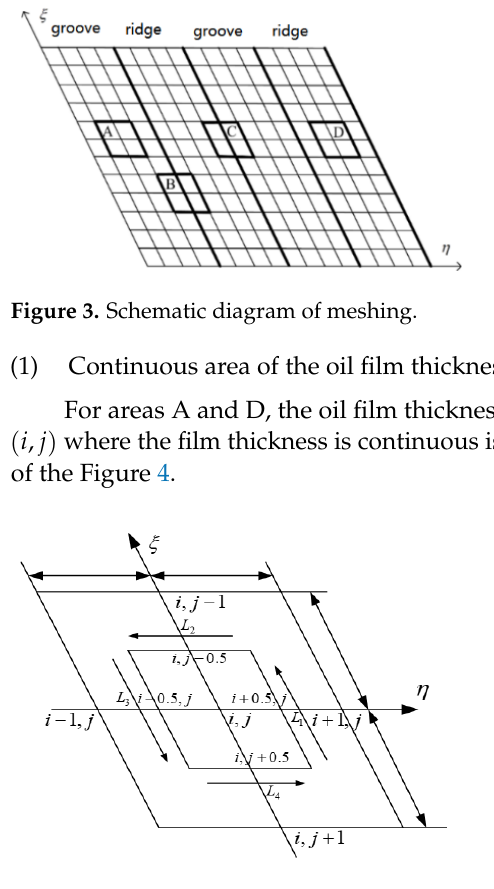
Figure 4. Continuous area of the oil film thickness.